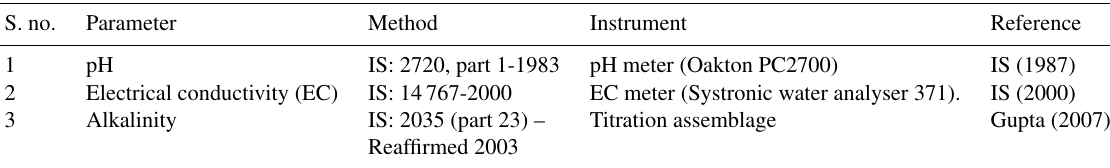
Table 2. Analysis of soil parameters. S.